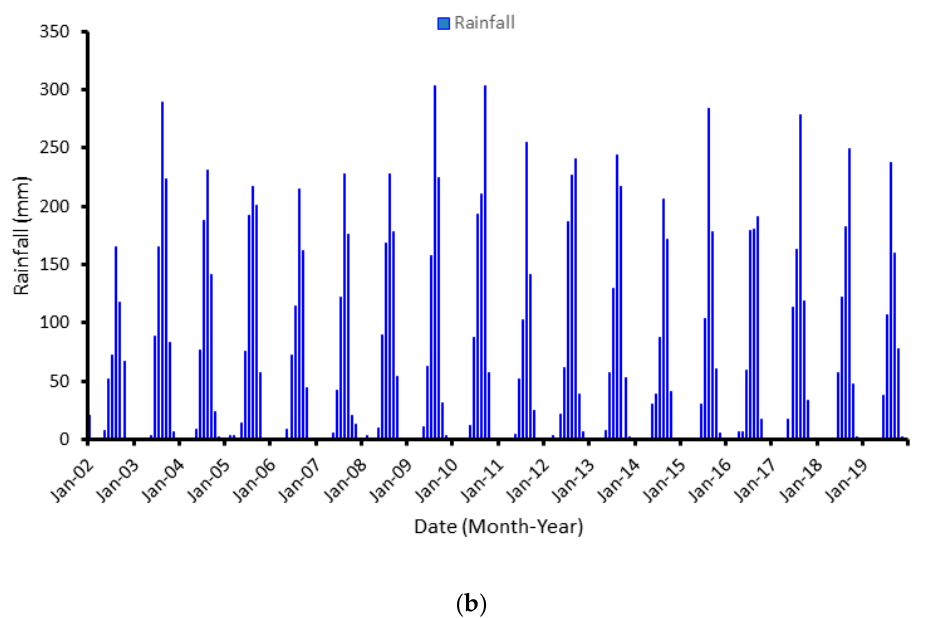
Figure 5. ( a ) The AAP extracted from TRMM data over the study area. ( b ) Monthly rainfall over the study region during the entire period. Three GLDAS models (VIC, NOAH, and CLM) were used to estimate the trend in the GLDAS-derived Δ SMS, Δ SWE, and Δ CWS trends. The Δ SWE and Δ CWS show no trends, however, the average Δ SMS was determined to be − 0.02 ± 0.01 mm/yr, showing a very slight negative trend during the entire period (Figure 6; Table 1).